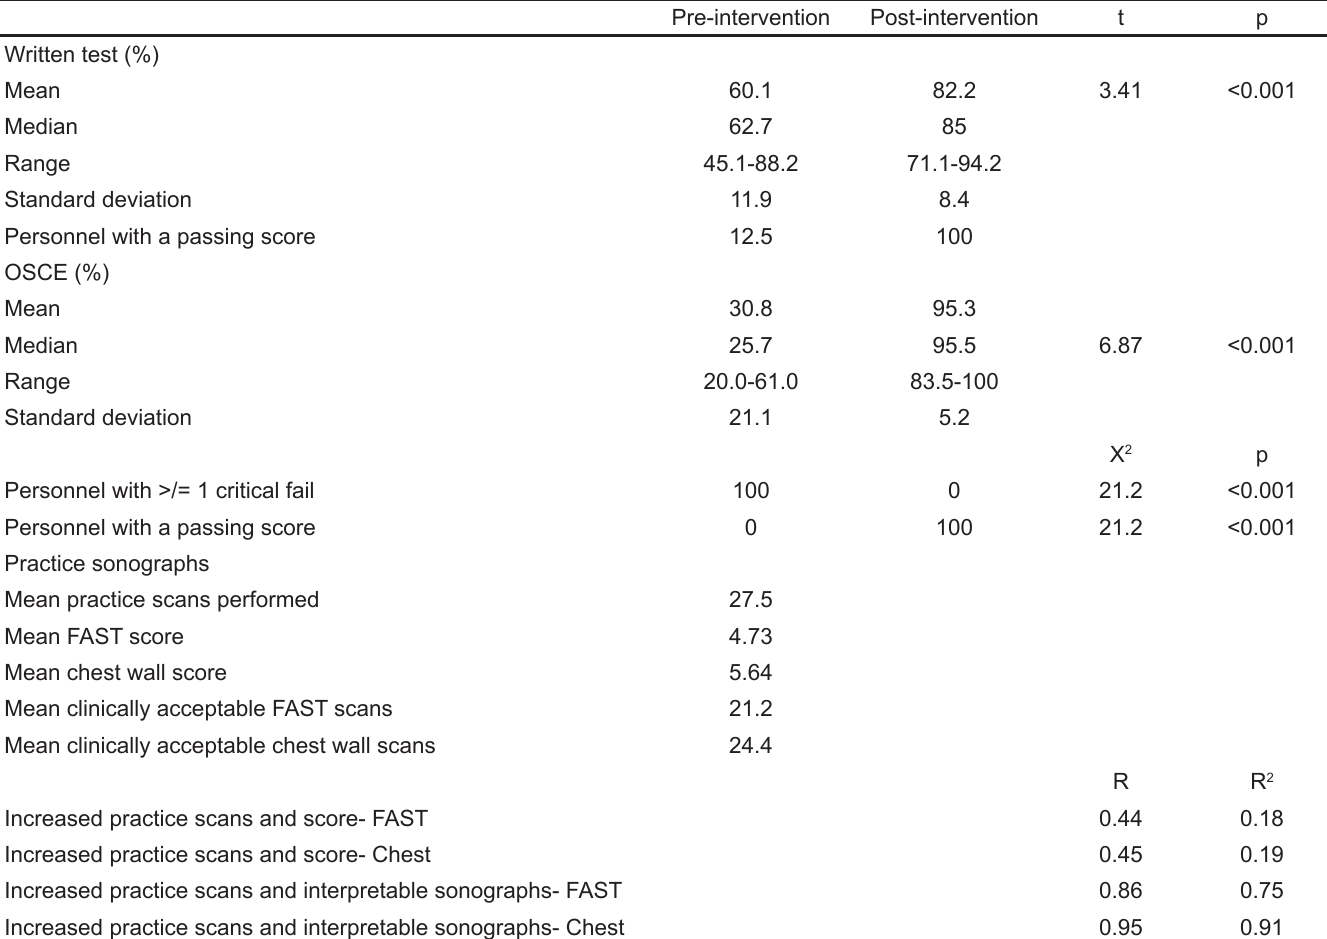
Table 3. Personnel proficiency